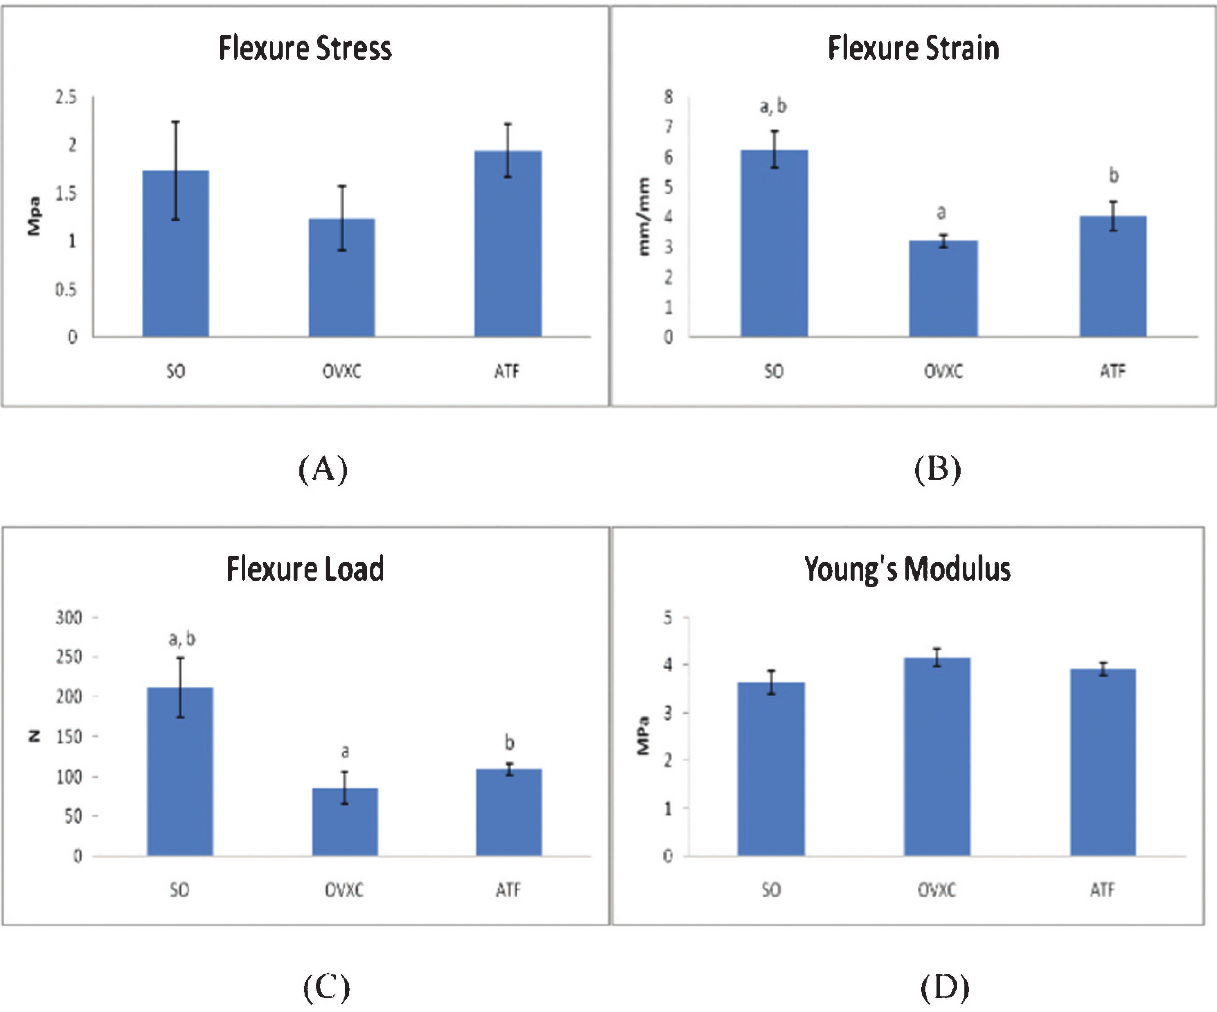
Figure 4 - (A) The bar chart illustrates the stress parameters derived from bone biomechanical testing. (B) The bar chart indicates the strain parameters derived from bone biomechanical testing. (C) The bar chart illustrates the load parameters derived from bone biomechanical testing. (D) The bar chart indicates the Young’s modulus values derived from bone biomechanical testing. SO: sham- operated group; OVXC: ovariectomized control group; ATF: ovariectomized + ATF-supplemented group; Values with the same alphabetical symbol are significantly different p ,